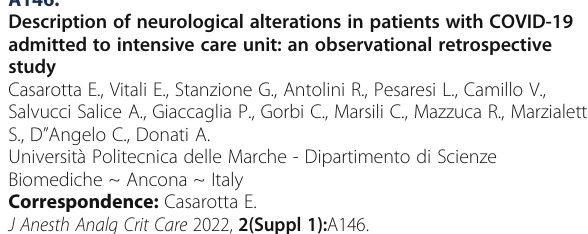
Table 1 (abstract A146). See text for